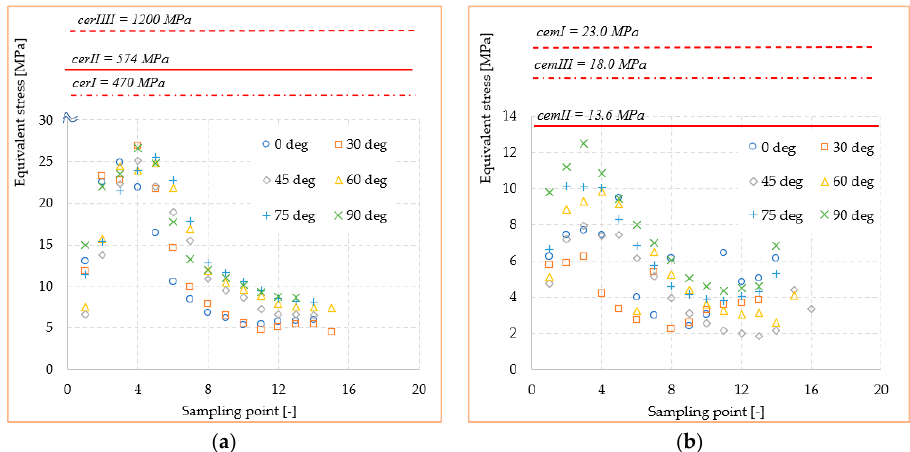
Figure 16. Mechanical strength of dental materials and equivalent stresses recorded at interface: ( a ) ceramic; ( b ) adhesive cement.